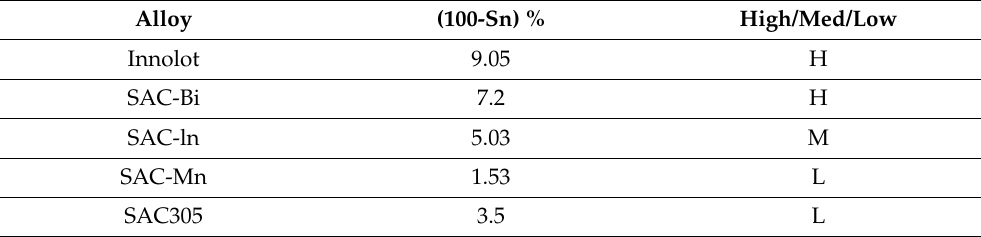
Figure 6. Summary of characteristic fatigue life and B10 for different alloys with, ( a ) ENIG; ( b ) ImAg, and ( c ) OSP surface finishes. Table 3. Element